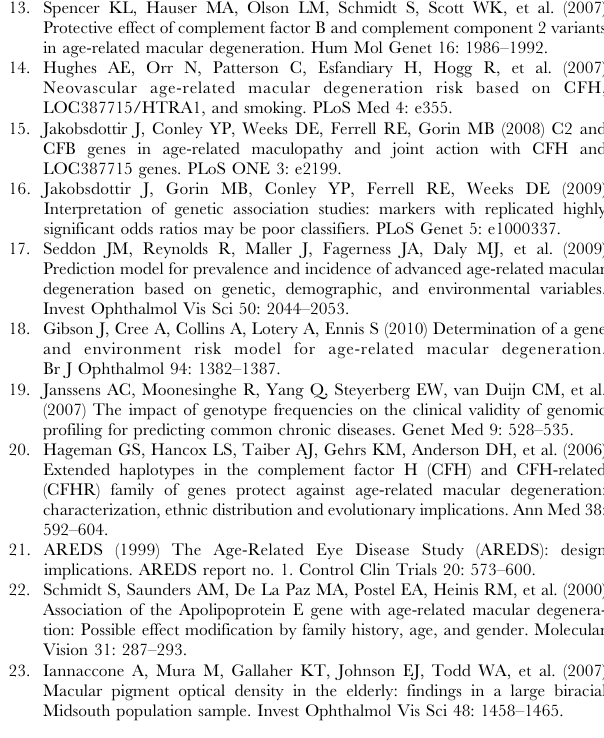
Figure S1 Neural network model developed in the VM training dataset. W =weight, PADD =addition function.